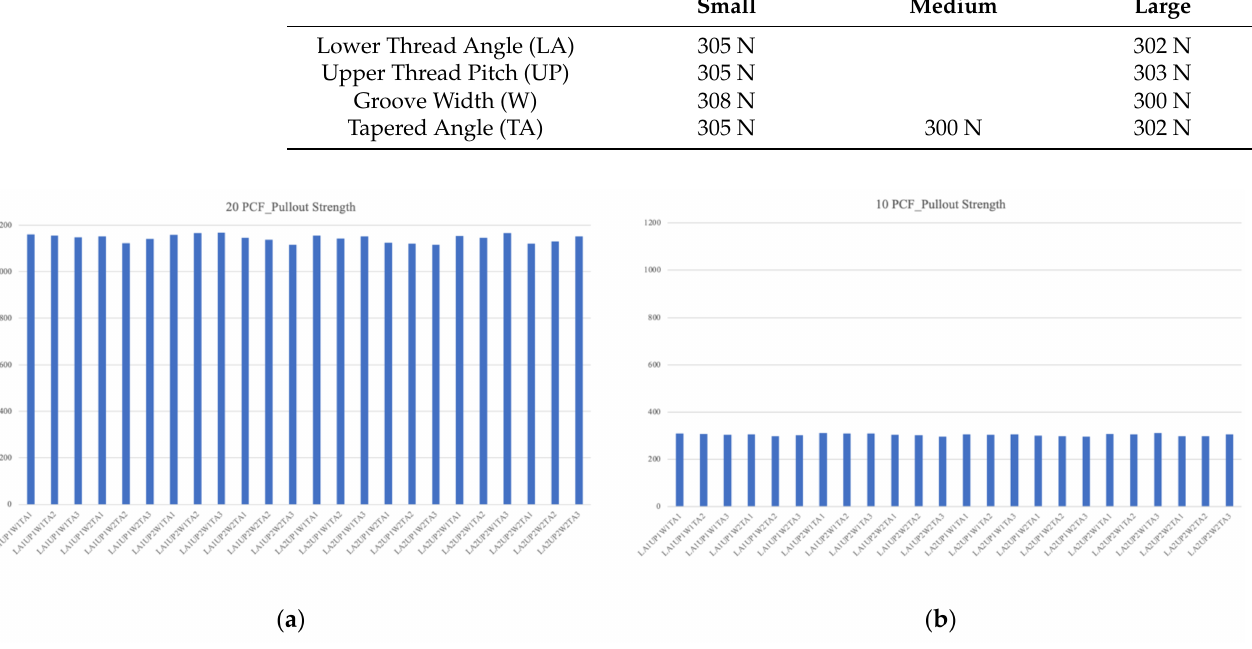
Figure 8. Comparison of pullout strength of 24 groups in ( a ) 20 PCF and ( b ) 10 PCF.